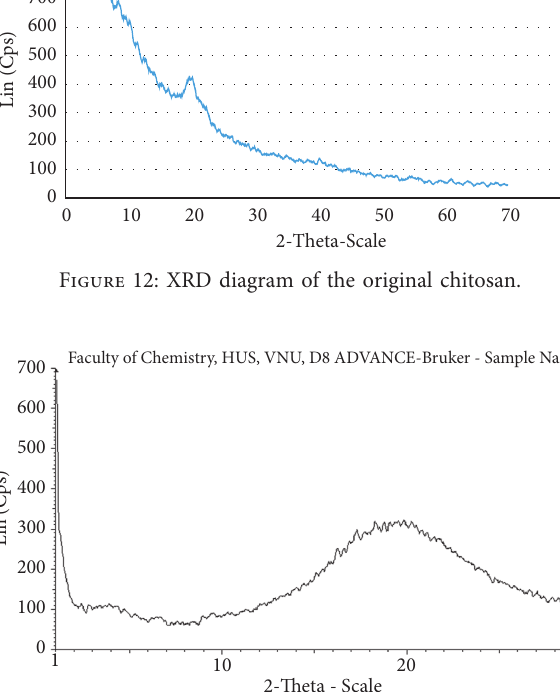
Figure 13: XRD diagram of chitosan/TPP manufactured at 6/3.